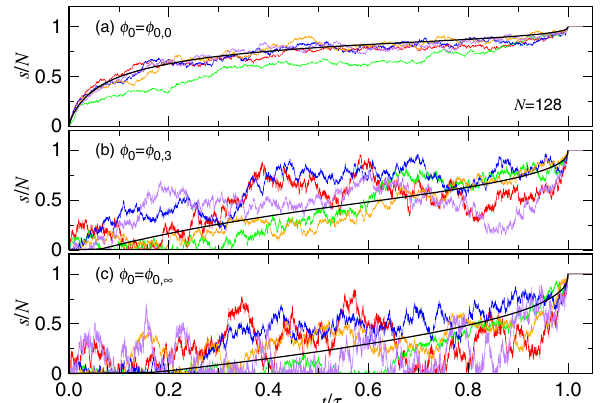
Figure 18. Evolution of the normalized coordinate s / N versus the normalize time t /τ in five typical ejection processes, plotted in colored curves, at ( a ) φ 0 N 128 . The mean evolution is plotted on top of the five curves in black color in each =